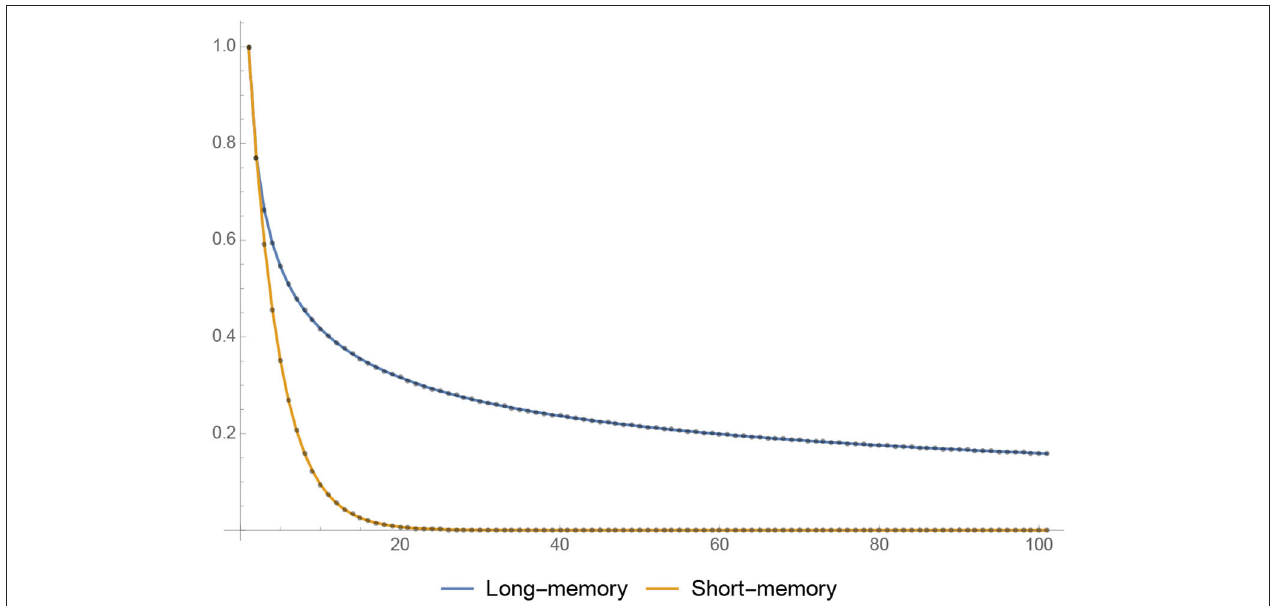
FIGURE 2 | First 100 autocorrelations of the original, short-memory (yellow) and the modified, long-memory (blue) processes, where the parameters are chosen such that the first-order autocorrelation is equal.